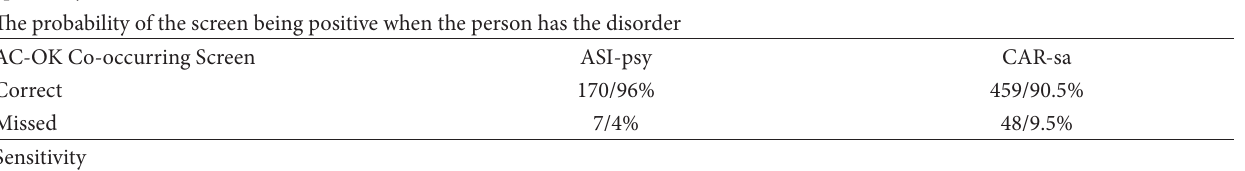
T 4: Speci�city and sensitivity AC-OK Co-occurring Screen agreement compared to two reference measures.